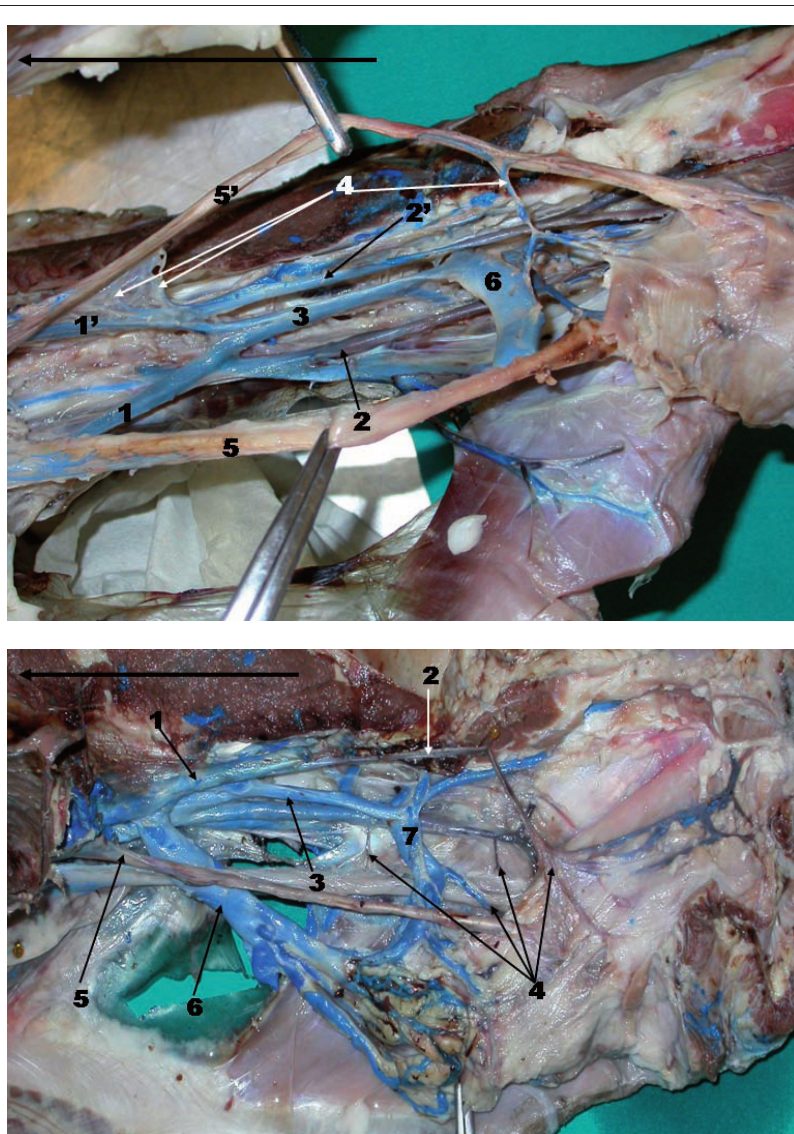
FIG. 7 Ventro-lateral view of the pel- vic region displaying the Vv. ili- acae internae dextra et sinistra (1, 1’), Vv. pudendae dextra et sinistra (2, 2’), V. mediana caudae (3), Vv. ureterodefer- entiales caudae (4), Ductus deferentes et ureteres dextrae et sinistrae (5, 5’), V. mesen- terica caudalis (6). Note the caudal ureterodeferential vein (4—single white arrow) drain- ing the ductus deferens (5) to the caudal mesenteric vein (6), Arrow top left indicates caudo- cranial direction. Latex injec-